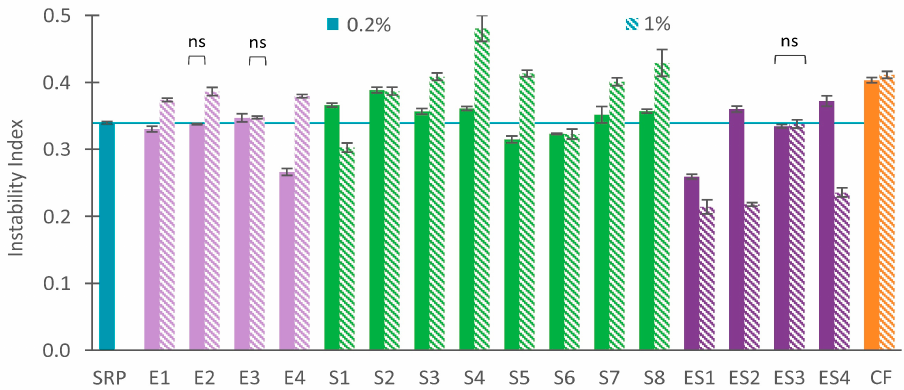
Figure 2. Instability index of SRP with 0.2 or 1% of dispersing agents (6 h at 300 × g ). Refer to Tables 1–4 for dispersing agent labels. Error bars depict sampling error. Values are significantly different from the control SRP ( p < 0.05) except for nonsignificant results (ns).